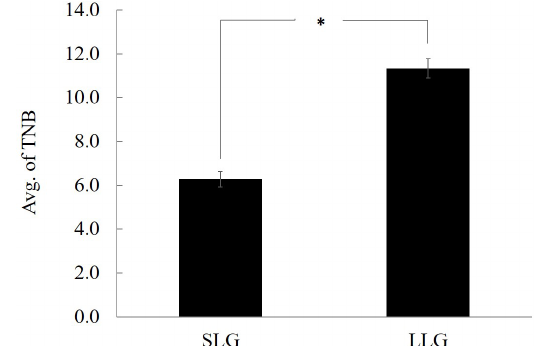
Figure 1. Comparison of average of TNB between SLG and LLG. The bars represent the mean ± SD; n = 3. ∗ Significantly differ- ent between both groups at p < 0 . 05. TNB: total number of piglets born; SLG: smaller litter size group; LLG: larger litter size